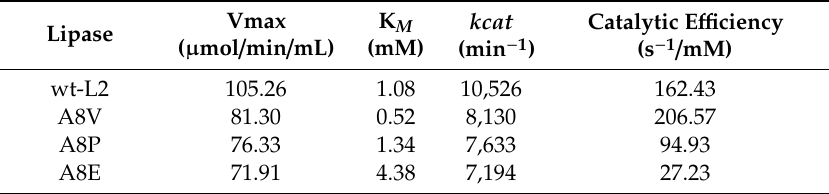
Table 4. The kinetic constants of wt-L2 and its mutants.